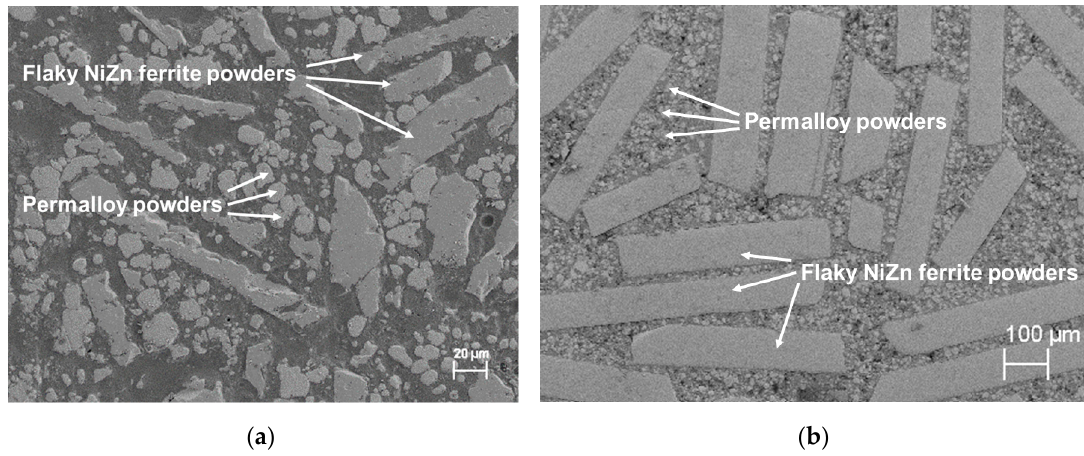
Figure 6. Cross-sectional SEM images of SM 2 Cs ( a ) Formulation A and ( b ) Formulation B.